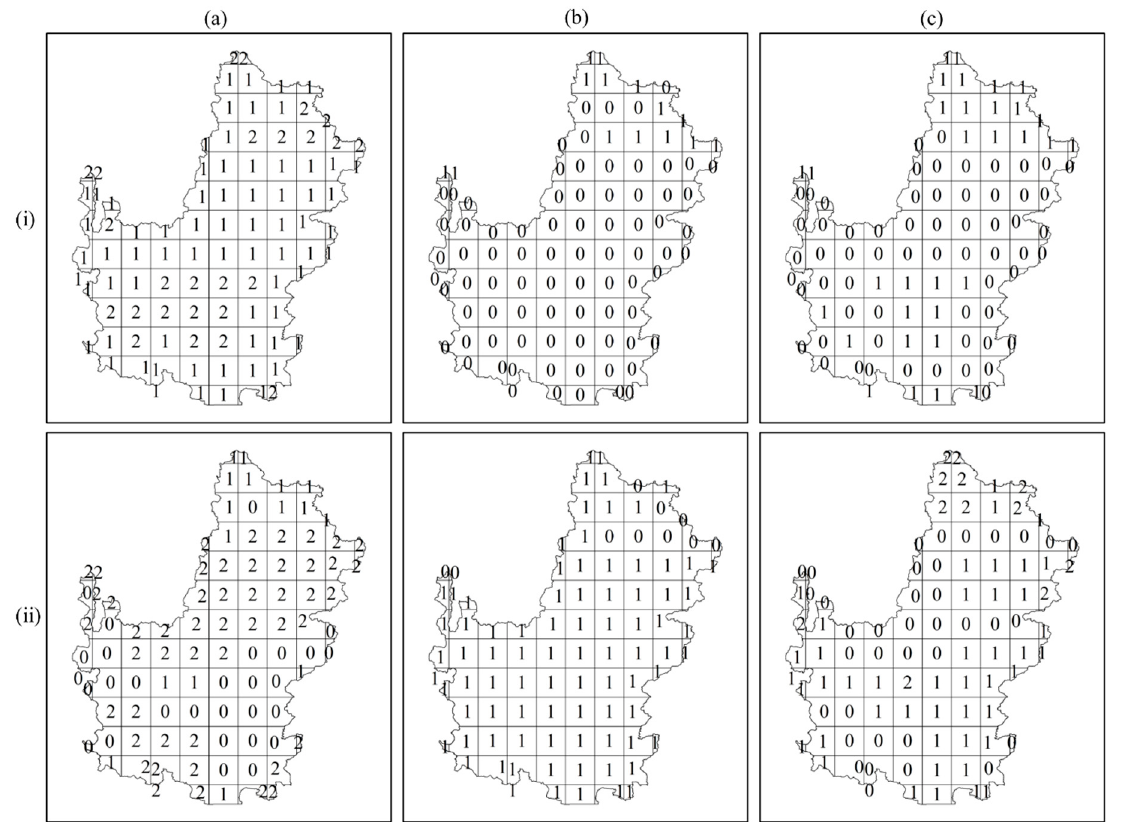
Figure 7. ARIMA model order for each grid cells representing ( a ) autoregressive term ( b ) differencing term and ( c ) moving average term for both ( i ) non-seasonal and ( ii ) seasonal component for the Colorado River Basin.